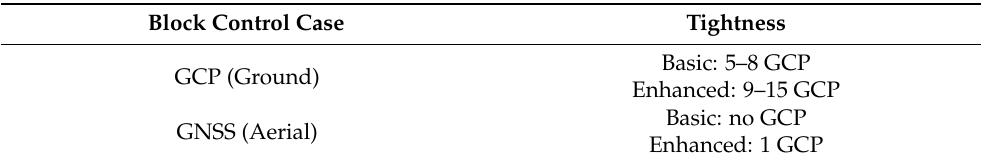
Table 3. The two block control cases each with two different tightness levels, depending on the number of GCP